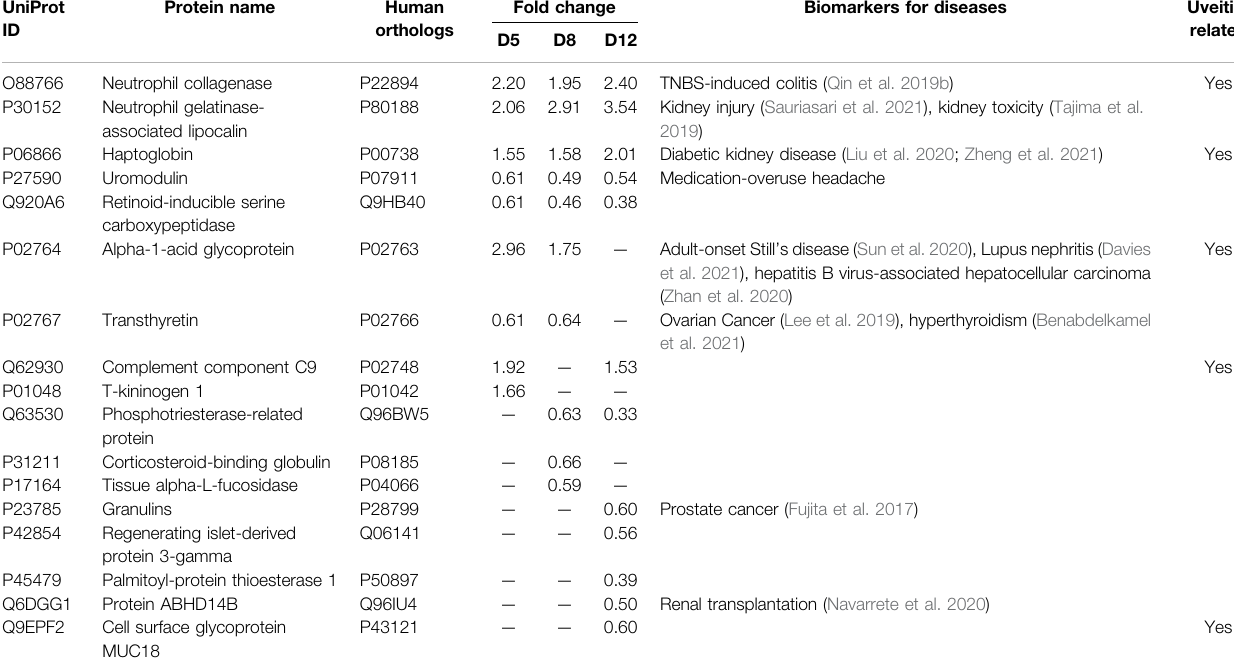
TABLE 2 | The details of differential urinary proteins validated by PRM analysis. UniProt